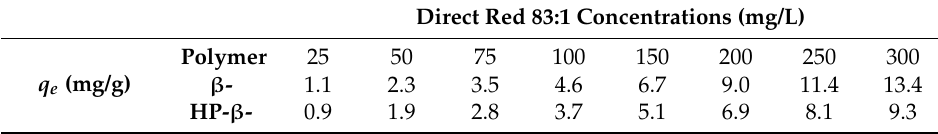
Table 1. Effect of the initial dye concentration on the adsorption capacity of the polymers. Direct Red 83:1 Concentrations (mg/L) q e (mg/g)